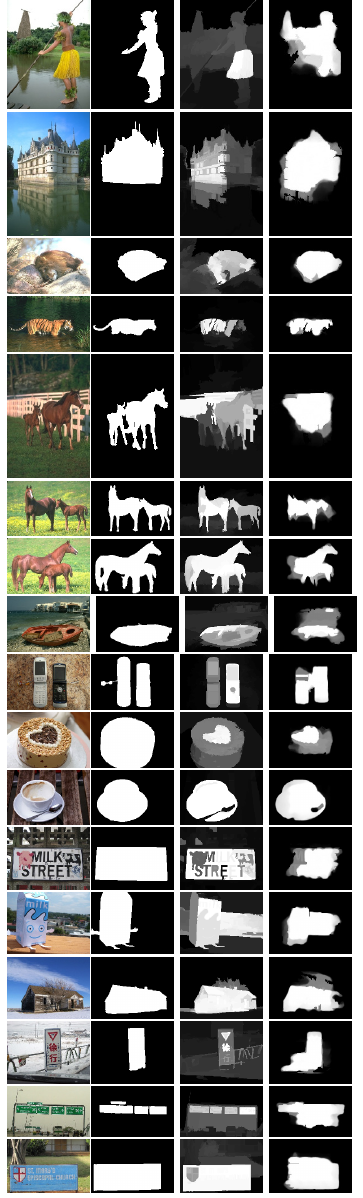
Figure 7. Visual comparison between our model and the state-of-the art CHS saliency model pre- sented in [68] on the first 8 images and last 8 images of the ECSSD dataset. From left to right: ECSSD image, ground-truth salient binary mask, CHS saliency map [68] and our UMESM saliency